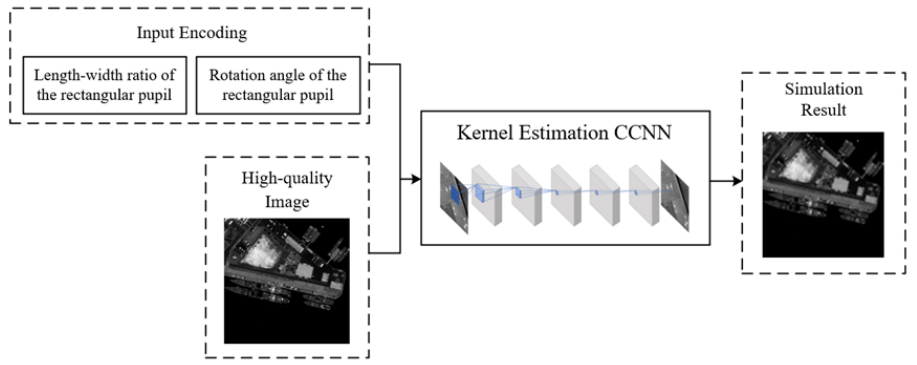
Figure 7. Flowchart of the image simulation method.